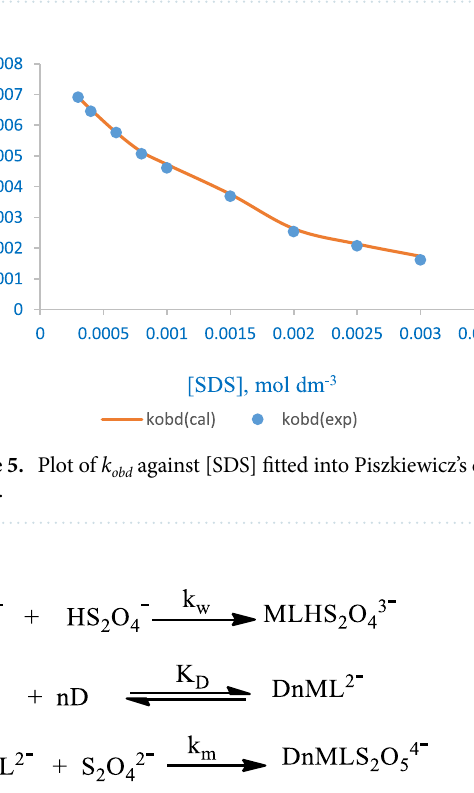
Figure 4. Rate dependent on temperature plot for the reduction of [Mo IV O 2 (paoH) 2 ] 2− by S 2 O 42− .